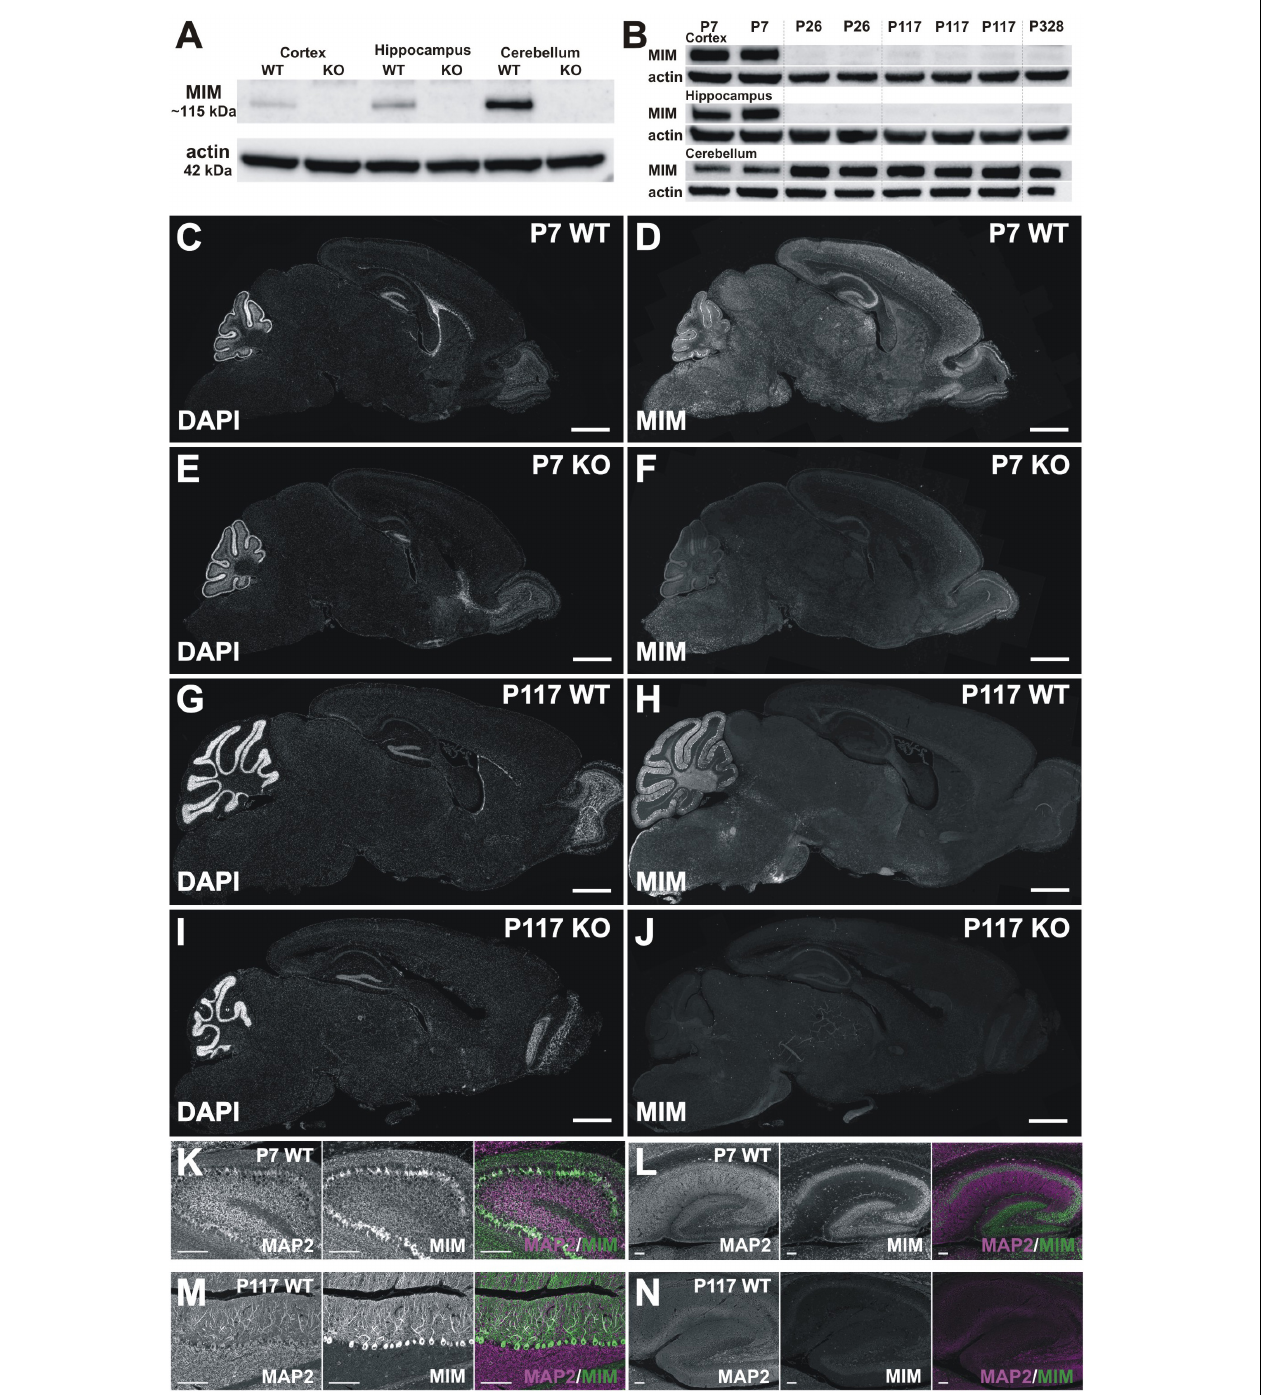
FIGURE 3 | MIM expression in the brain. (A) Western blot data show that the MIM protein is not expressed in MIM KO mouse brain, and in WT P7 mice the highest MIM expression is in the cerebellum, while hippocampi and cortices have a lower MIM expression. In SDS-PAGE gel, MIM protein runs above 100 kDa size marker, around 115 kDa, whereas actin runs by 42 kDa. All samples, 35 µ g of protein. (B) Cortex, hippocampus and cerebellum samples of 2 P7 WT mice, 2 P26 WT mice, 3 P117 WT mice and 1 P328 WT mice were run on SDS-PAGE gel and blotted against MIM and actin. MIM is expressed through the mouse life in cerebellum whereas in hippocampus and cortex it is expressed at higher amount only at P7. Cerebellum samples 40 µ g, Cortex and hippocampus samples, 80 µ g of protein. (C–J) Sagittal WT and KO brain sections stained for MIM (D,F,H,J) and counterstained for DAPI (C,E,G,I) . Shown are brain sections of P7 (C–F) and P117 (G–J) mice. Scale bars: 1000 µ m. (K–N) Cerebellum (K,M) and hippocampus (L,N) in higher magnification from same sections as shown in panel C–J at same intensity to visualize MIM expression in Purkinje cells and granule cells in cerebellum (K,M) and in pyramidal and granule cells in hippocampus (L,N) at different ages (P7, P117). Scale bars: 100 µ